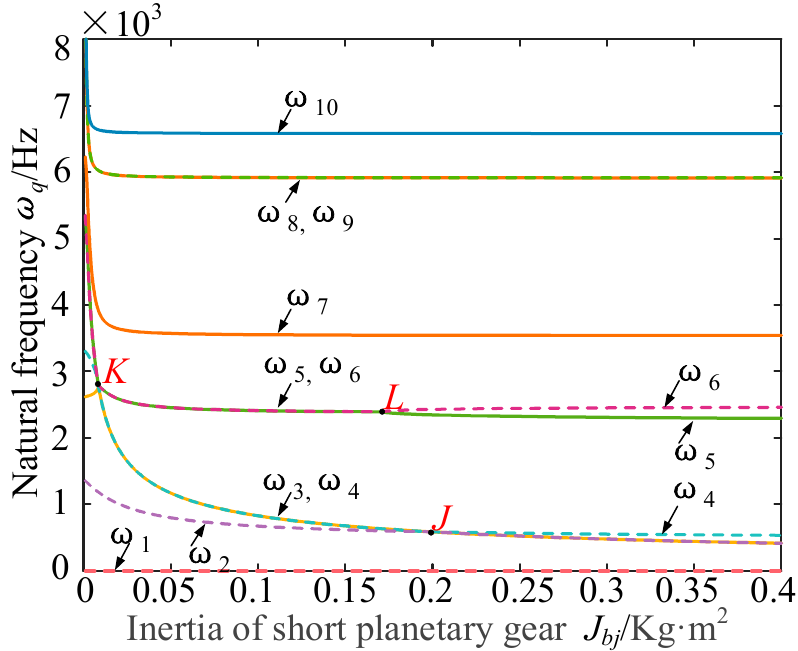
. (cid:3028)(cid:3037)